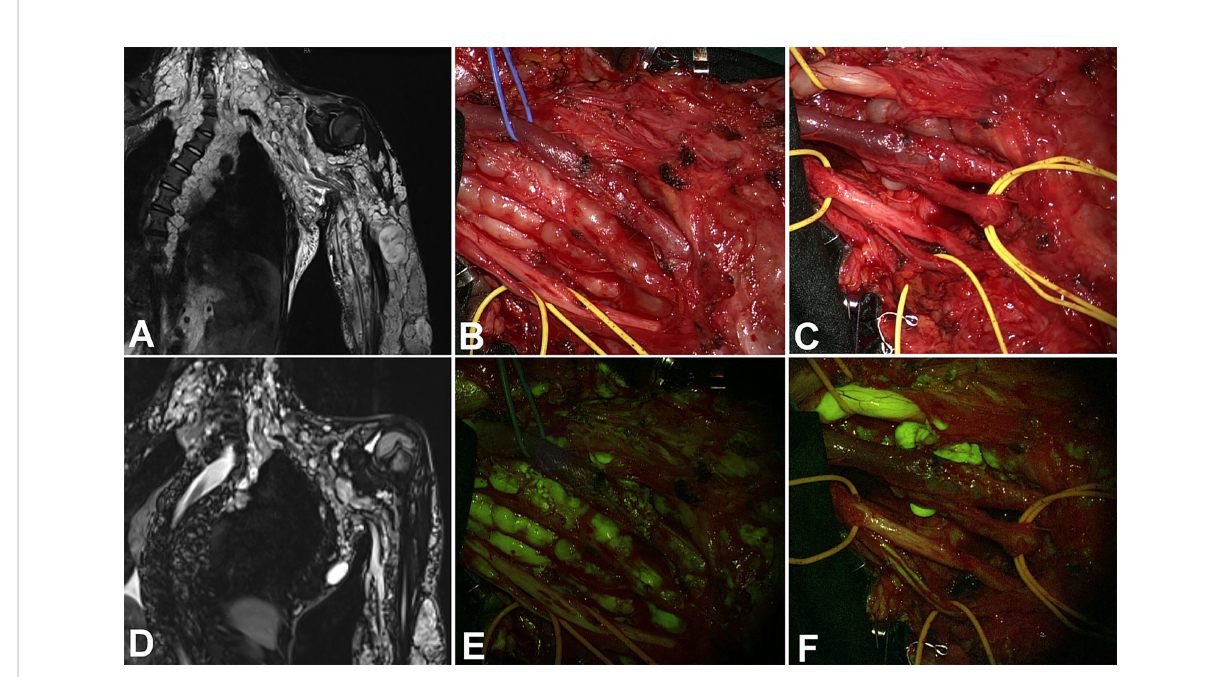
FIGURE 3 Coronal view in a huge plexiform neuro fi broma of the whole upper left arm. Due to the rapid increase of a nodular lesion between radial and median nerves, the patients underwent partial surgery (coronal view in (A) – preoperative – and D – postoperative), with progressive exposure of the nerves by alternating the white light (B, C) and the YELLOW560 fi lter activation (E, F) . The tumor showed intense fl uorescence if compared to the moderate fl uorescein uptake of the nerve, whereas the neuro fi broma partially substituted the radial nerve (F)